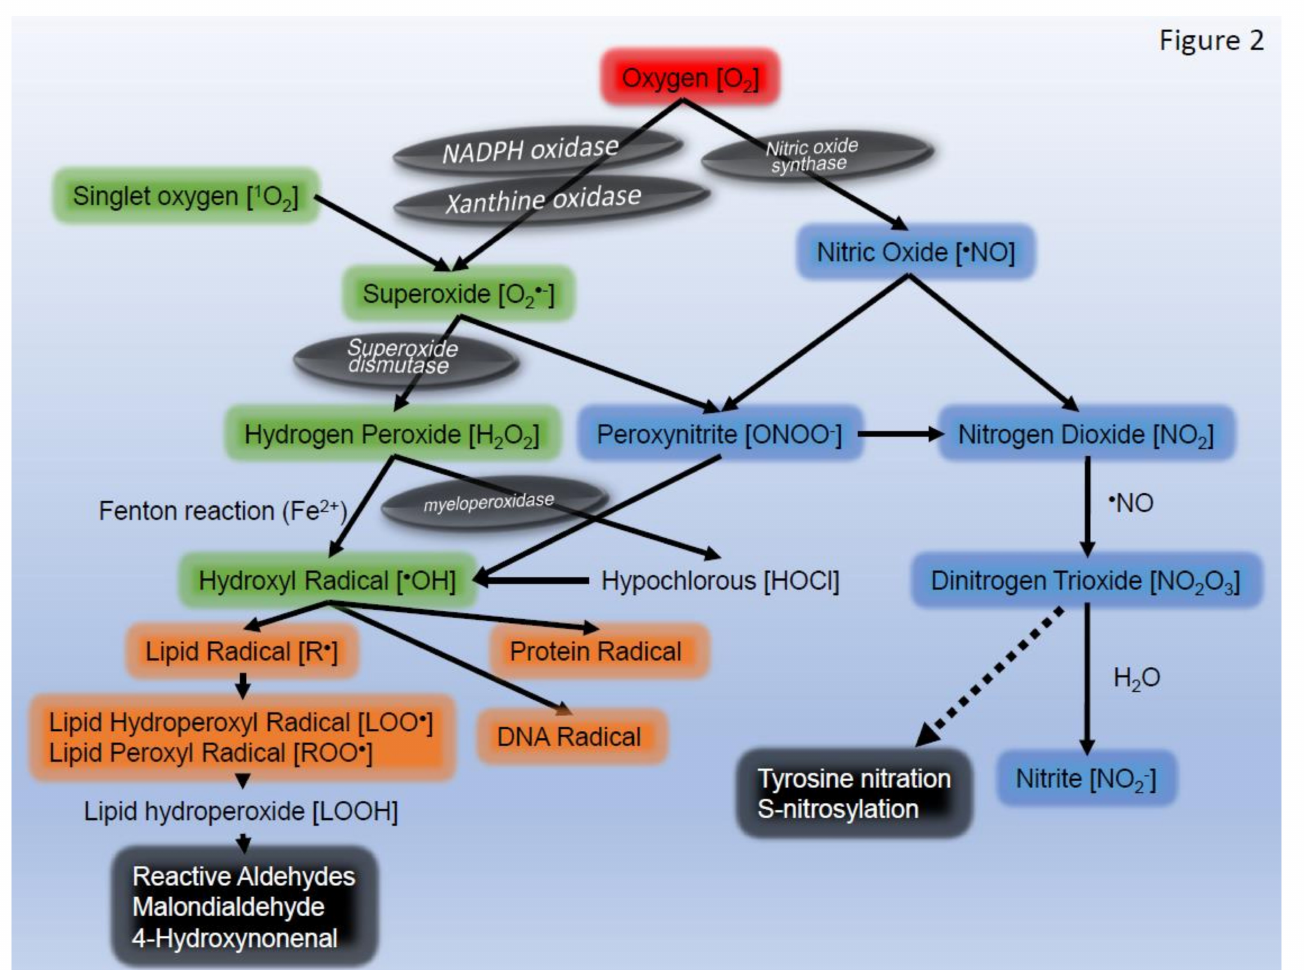
Figure 2. Reaction pathway of reactive oxygen species and free